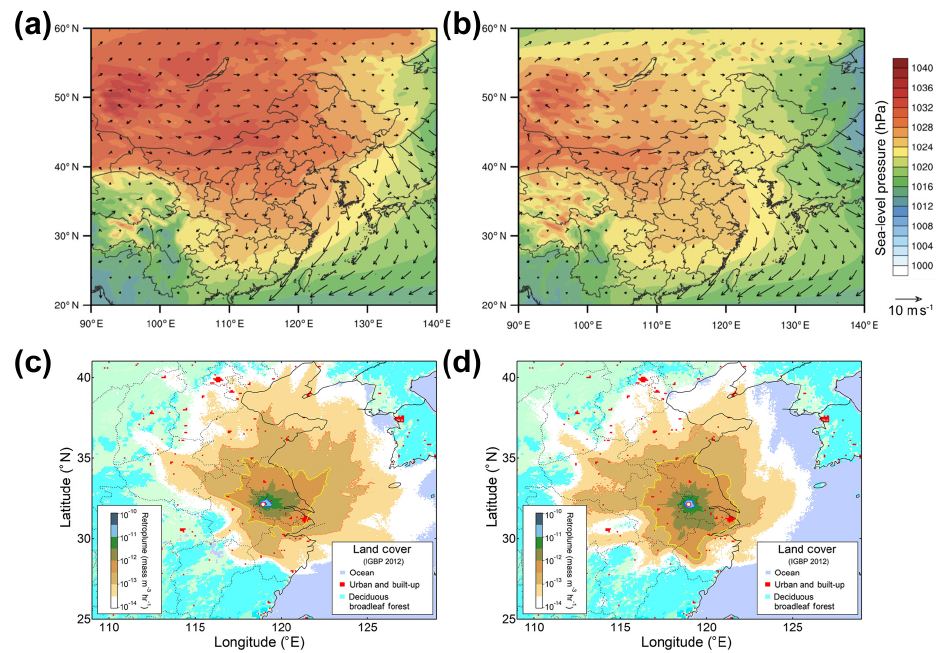
Figure 9. Averaged sea-level pressure and wind flows for (a) November 2011–January 2012 and (b) November 2013–January 2014, and in (c) and (d) averaged retroplume from 2d backward Lagrangian dispersion modeling for the corresponding period in (a) and (b) , respectively, is